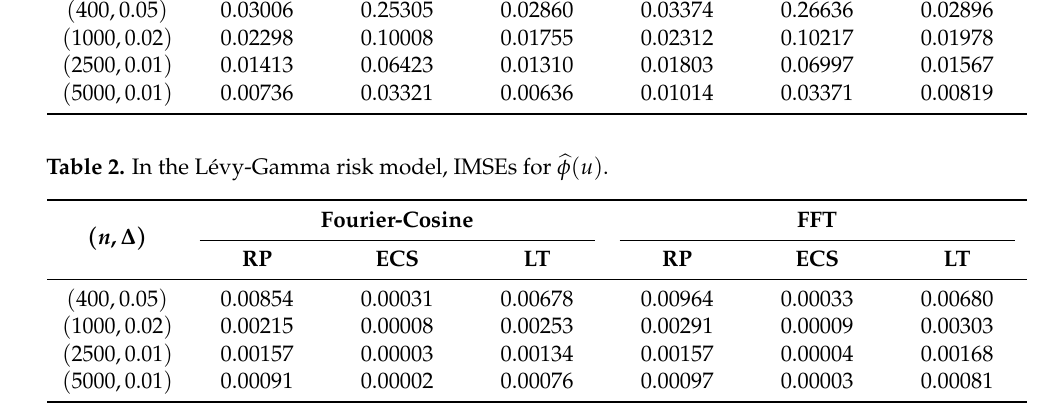
Table 1. In the compound Poisson risk model, IMSEs for (cid:98) φ ( u ) . ( n , ∆ )